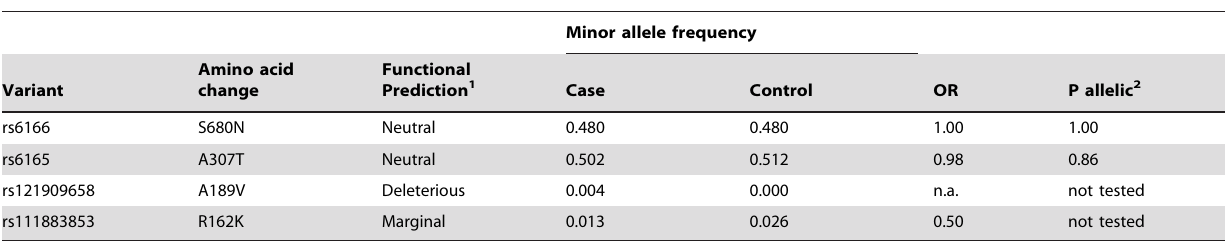
Table 2. Nonsynonymous SNVs identified in